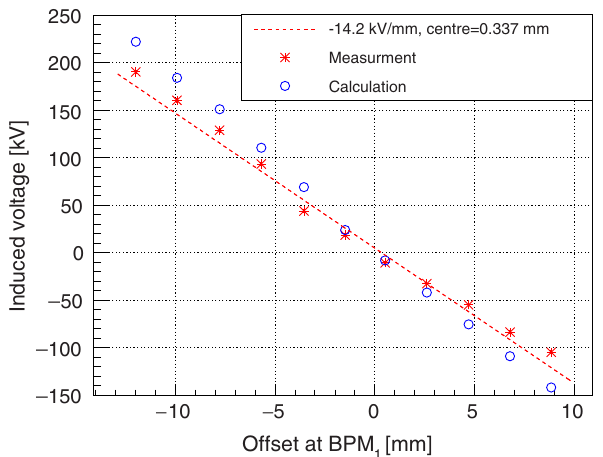
FIG. 4. Beam loading measurements as a function of beam offset for cavity 1 compared to expected values. The electrical center is similar for cavity 2 and within the specified tolerance of ≤ 500 μ m